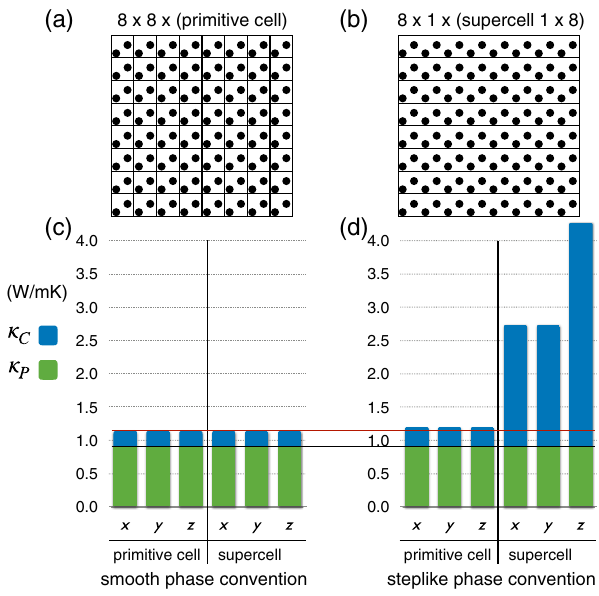
FIG. 2. Size consistency of the LWTE conductivity in the smooth phase convention. Size consistency is tested computing the conductivity Eq. (47) of a silicon crystal at T ¼ 300 K and using a fictitious linewidth of ℏ Γ ð q Þ s ¼ 30 cm − 1 ∀ q ; s (see text). We sketch in (a) and (b) two equivalent crystal representa- tions: (a) repeating a two-atom primitive cell the same number of times along each Cartesian direction, (b) repeating a 16-atom unit cell that is larger than the primitive. Panel (c) shows that the smooth phase convention [used in Eq. (7)] yields size-consistent numerical results, since the conductivity is unchanged when the silicon crystal with fictitious linewidths is modeled as (i) a 16 × 16 × 16 repetition of the two-atom primitive cell and (ii) a (physically equivalent) 2 × 2 × 16 repetition of a unit cell that is a supercell 8 × 8 × 1 of the primitive. Panel (d) shows instead that the steplike phase convention [used in Eq. (9)] is not size consistent, since it yields different conductivities for the two physically equivalent representations of the crystal. The black and red lines serve as a guide to the eye, to show that the Peierls- Boltzmann (populations) conductivity does not depend on the phase convention adopted (black), while the coherences conduc- tivity depends on the phase convention adopted